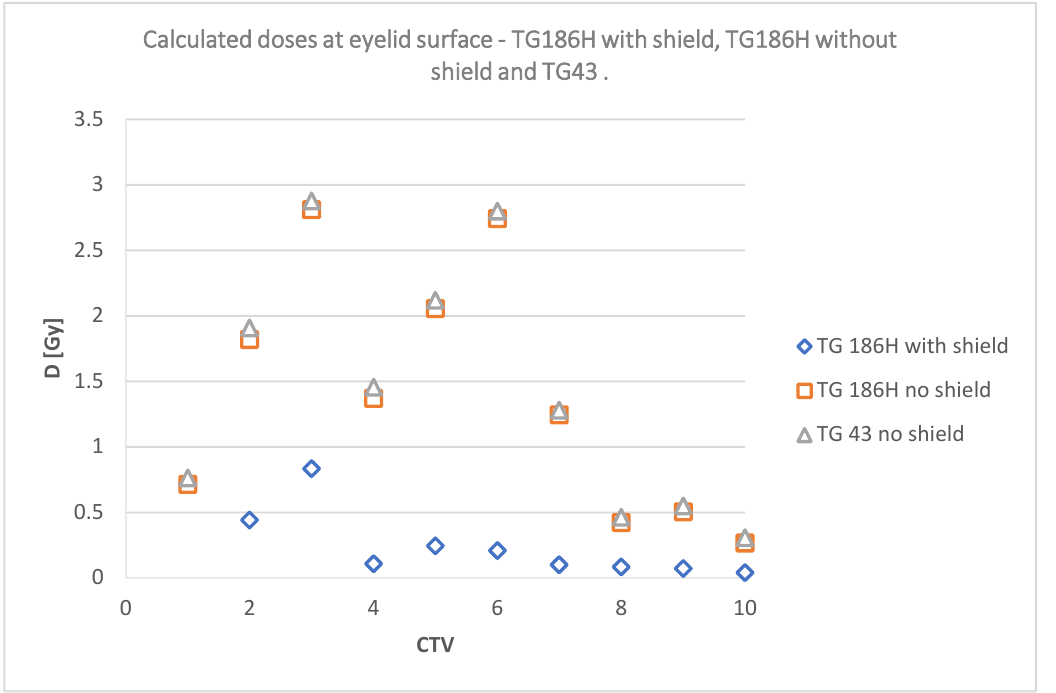
Figure 11. Calculated doses comparison—TG186H with shield, TG186H without shield, and TG43 on the eyelid surface of the right eye.